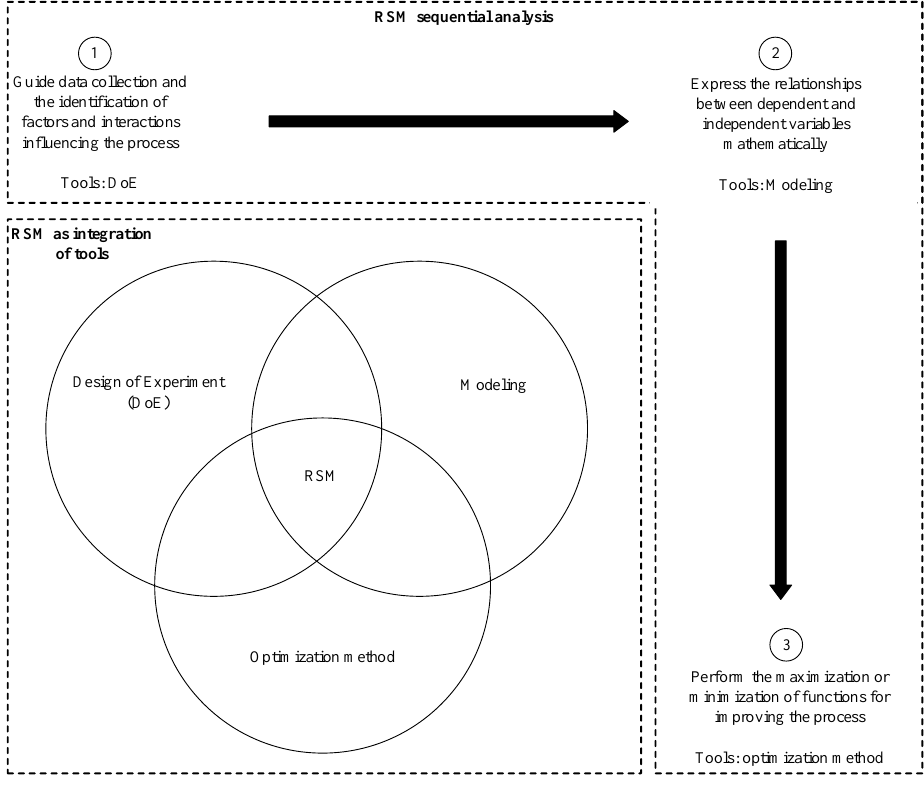
Figure 1. Overview of RSM (adopted from [19]).